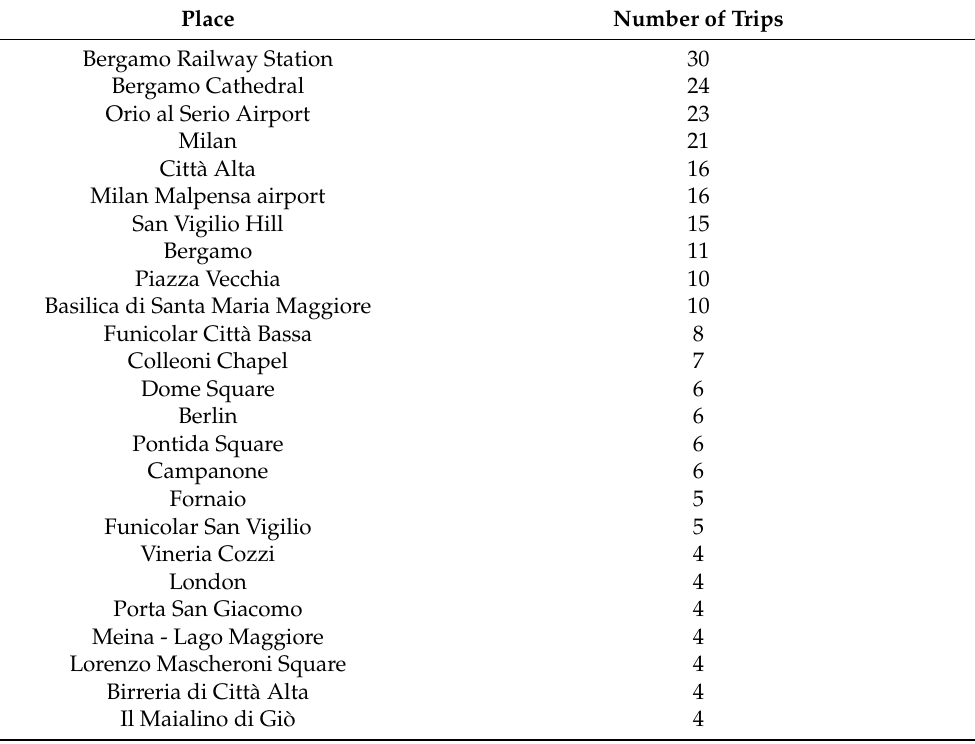
Table 3. Places the appear in the case-study data set, with the number of trips in which they occur. Place Number of